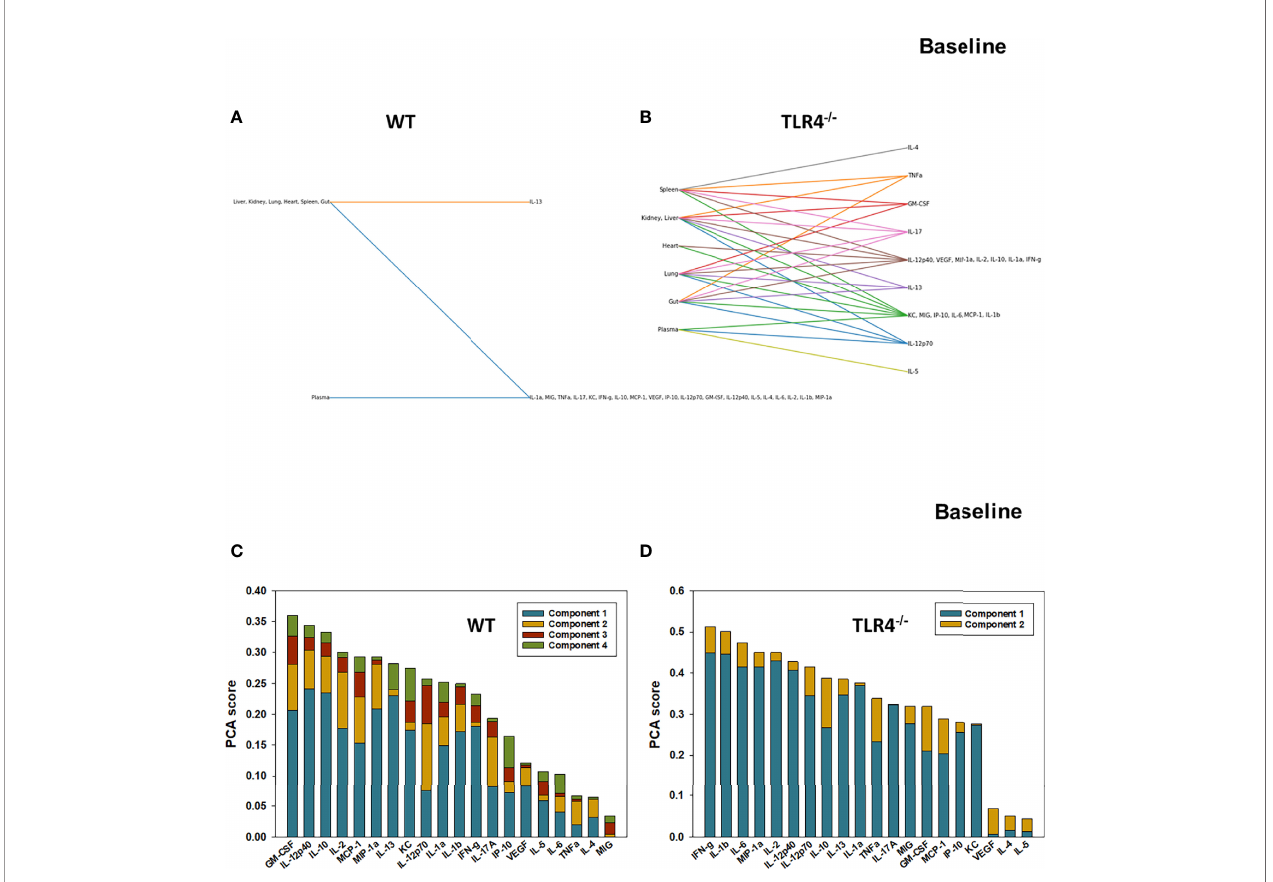
FIGURE 2 | Hypergraphs and Principal Component Analysis suggest differential baseline in fl ammatory responses in WT and TLR4 -/- mice. Plasma and tissue samples from heart, lung, liver, gut, spleen, and kidney were collected from untreated (Ctrl) WT and TLR4 -/- mice and analyzed using Luminex ™ as described in Materials and Methods. Panels (A, B) show the hypergraphs and Panels (C, D) show the PCA results (70% variance) in WT and TLR4 -/- mice,